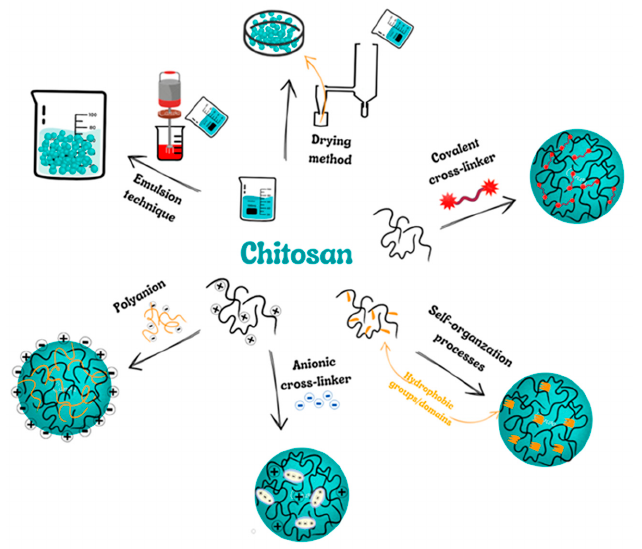
Figure 2. Scheme presenting the most popular methods of chitosan nanoparticles (ChNPs) produc-